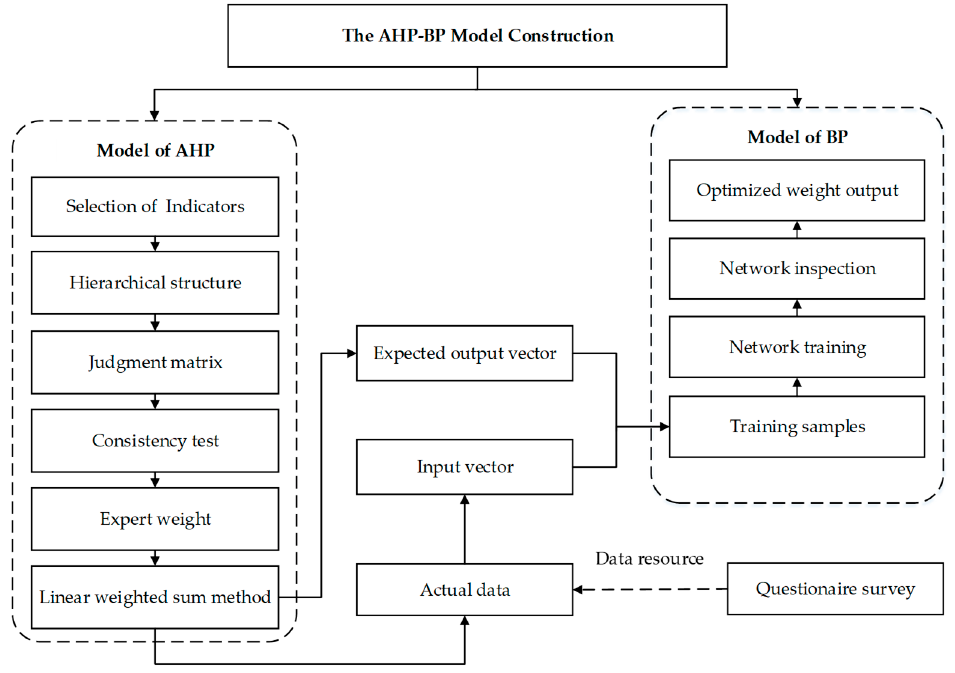
Figure 2. Analytic hierarchy process–back propagation (AHP-BP) model of building process diagram.